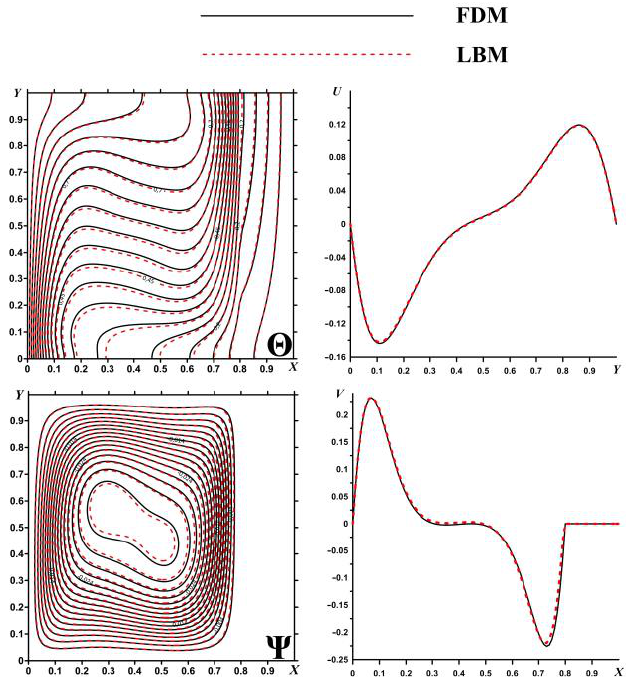
Figure 2. Isotherms Θ, streamlines Ψ, U and V velocity components obtained using different numerical methods.